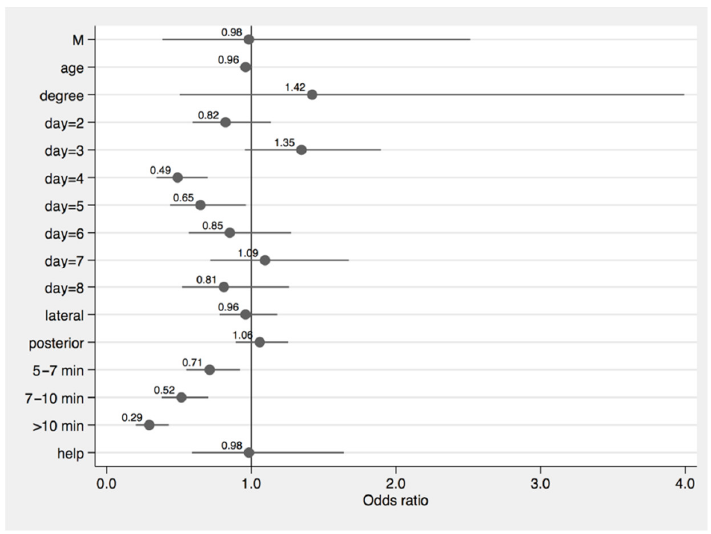
Figure 6. Effects of several independent variables on the probability of obtaining good quality images during LUS evaluation (M: male vs. female).